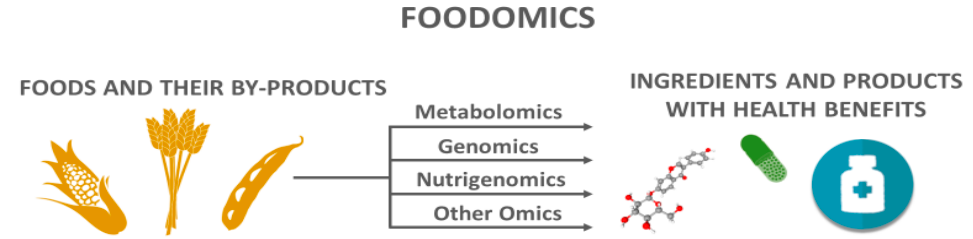
Figure 1. Foodomics proposes a holistic approach to develop ingredients and products with health benefits from foods and their by-products.